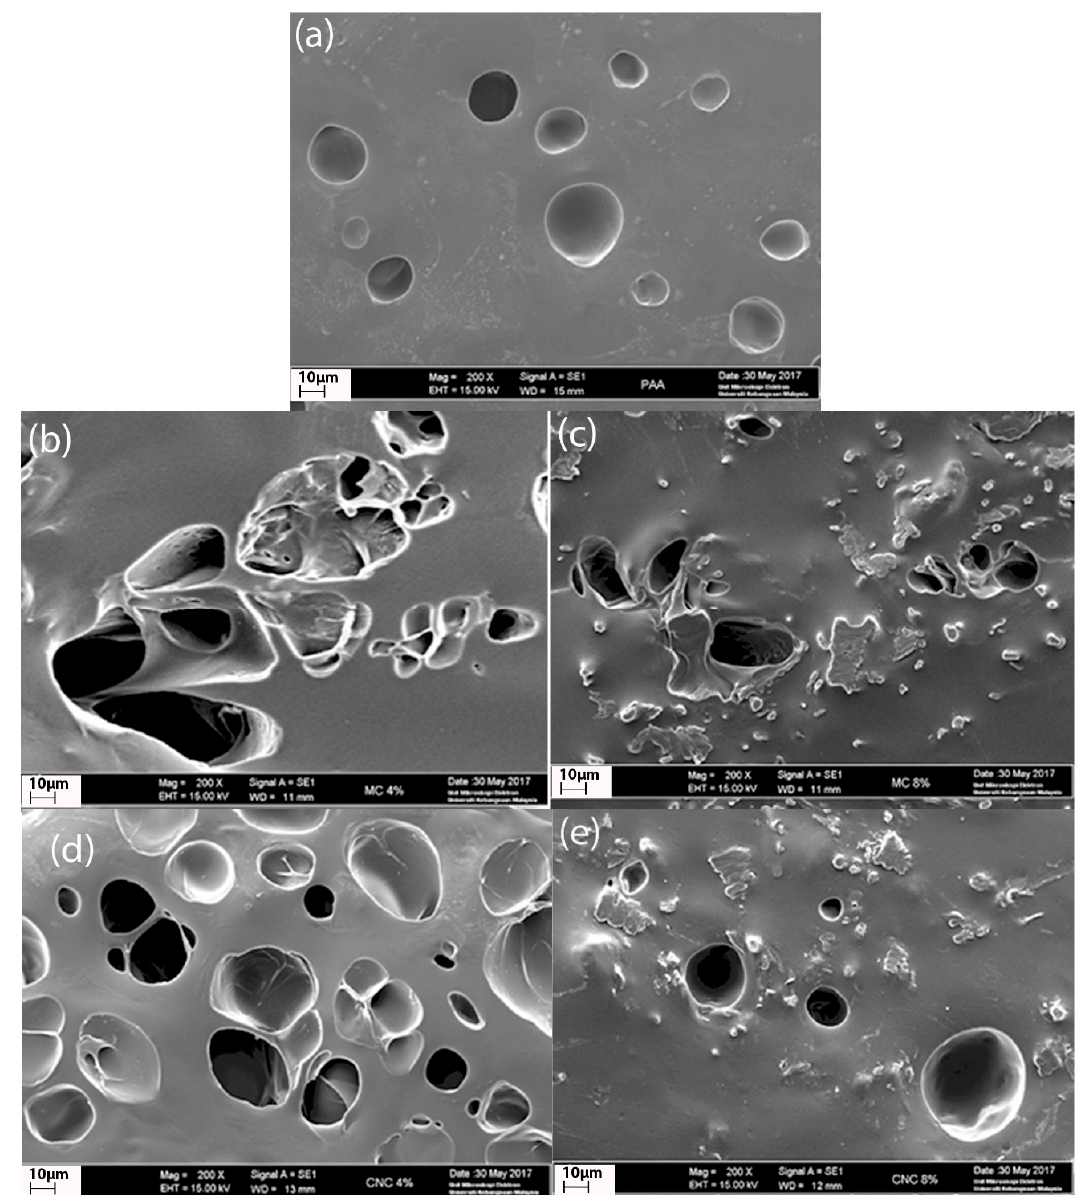
Figure 9. SEM micrographs of ( a ) PAA hydrogels, ( b ) PAA / 4% cellulose hydrogels, ( c ) PAA / 8% cellulose hydrogels, ( d ) PAA / 4% CNC hydrogels, and ( e ) PAA / 8% CNC hydrogels.